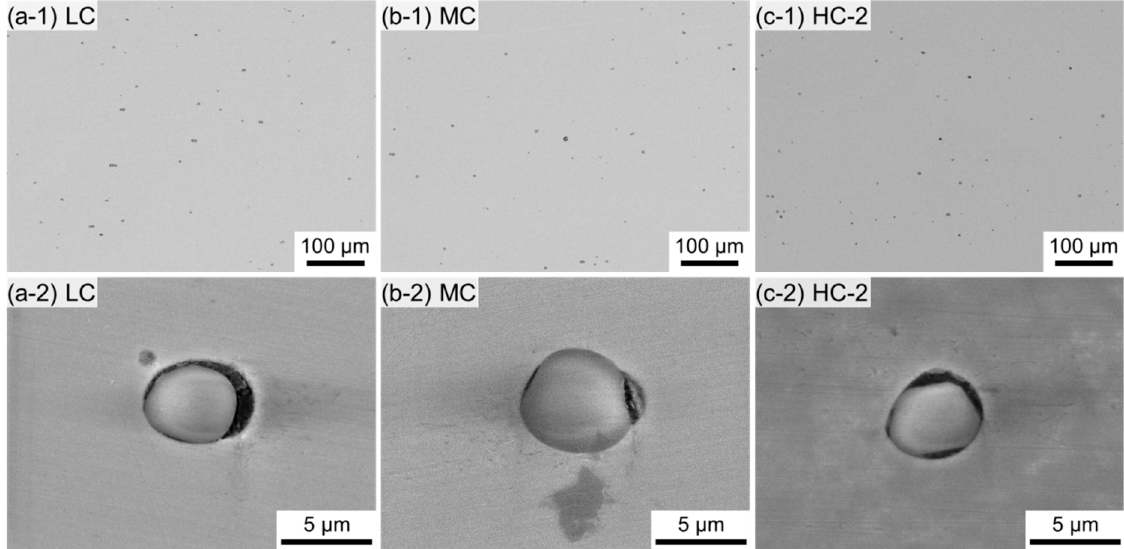
Figure 7. Non-metallic inclusions (NMIs) of the ( a ) LC, ( b ) MC, and ( c ) HC-2 samples: ( a-1 , b-1 , c-1 ) back-scattered electron (BSE) images showing the distribution of NMI and ( a-2 , b-2 , c-2 ) secondary electron (SE) images for each NMI of the samples.